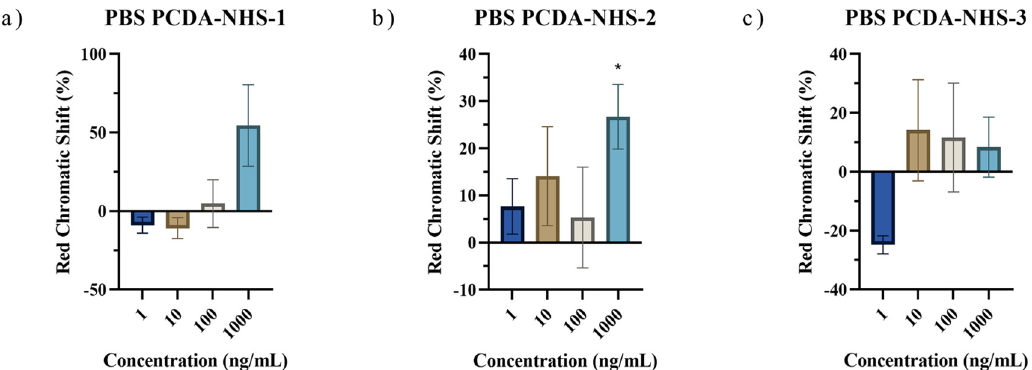
Figure 6. Red chromatic shift for PBS samples after 4 hours of incubation. RCS data was obtained from sensors of PCDA-NHS-1 ( a ), PCDA-NHS-2 ( b ), and PCDA-NHS-3 ( c ) groups after 4 h of incubation in solutions containing various concentrations of the SARS-CoV-2 spike protein in PBS buffer (* p < 0.05).